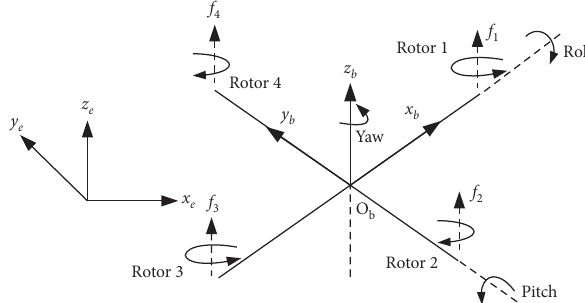
Figure 1: Schematic diagram of the quadrotor